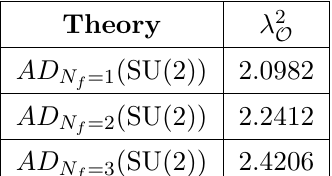
obtained from the RMT approach (including O